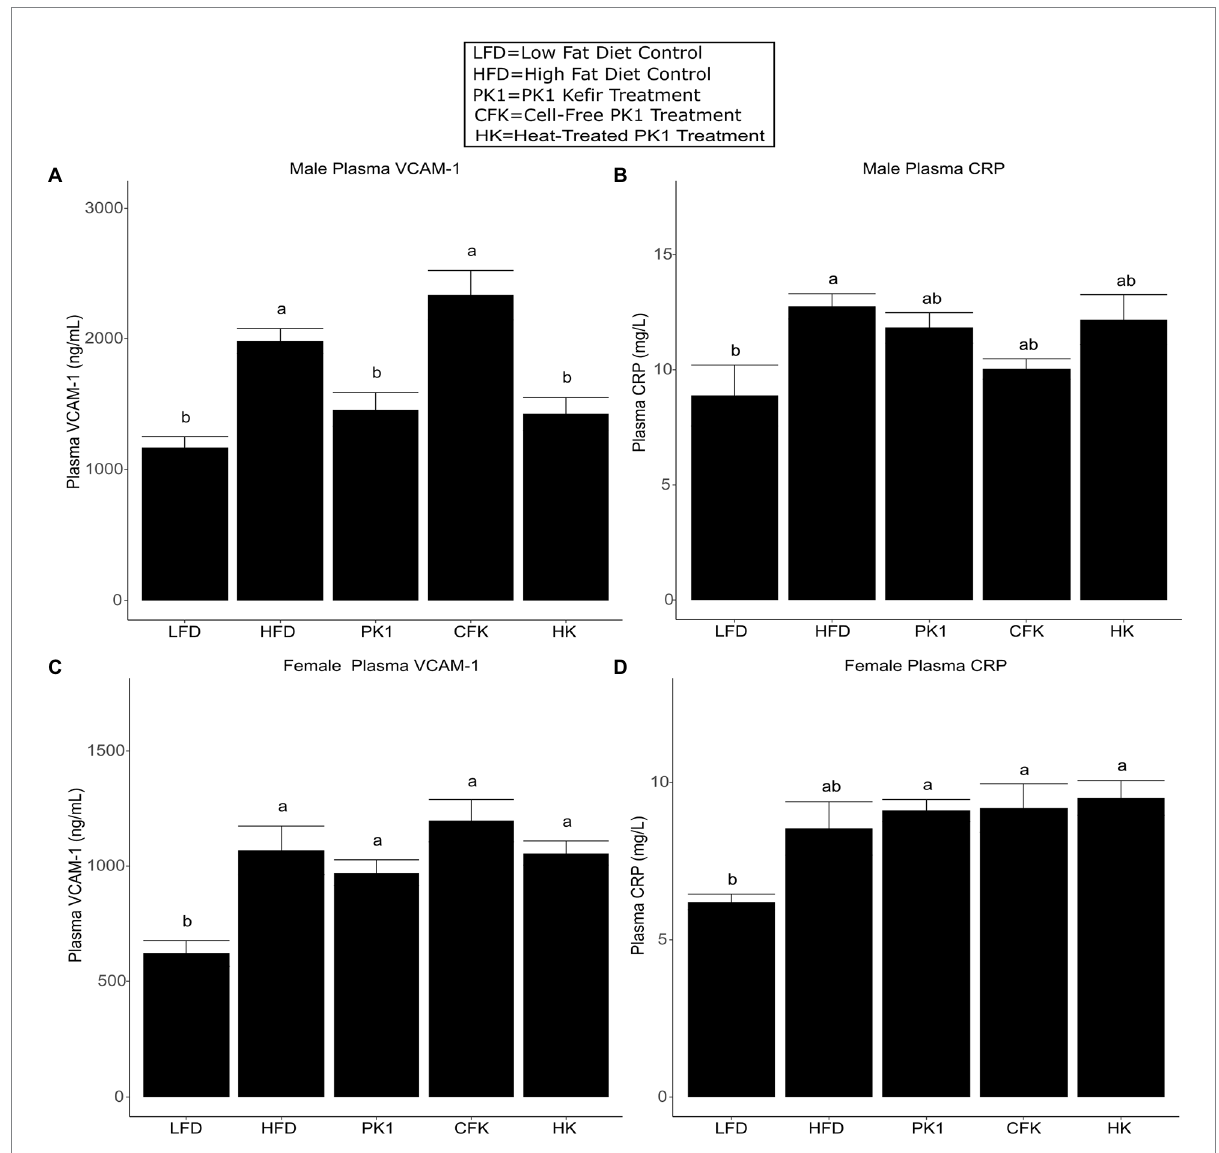
FIGURE 4 Concentration of plasma VCAM-1 (A,B) and CRP (C,D) in male/female C57Bl/6 mice fed a control diet or high-fat diet supplemented with milk or different kefir preparations for 8 weeks. Data are expressed as mean values with their standard errors ( n = 7–8). Means that do not share a letter are significantly different ( p < 0.05). LFD, mice fed a low fat diet supplemented with freeze-dried milk for 8 weeks; HFD, mice fed a high fat diet supplemented with freeze-dried milk for 8 weeks; PK1, mice fed a high fat diet supplemented with freeze-dried pitched kefir for 8 weeks;